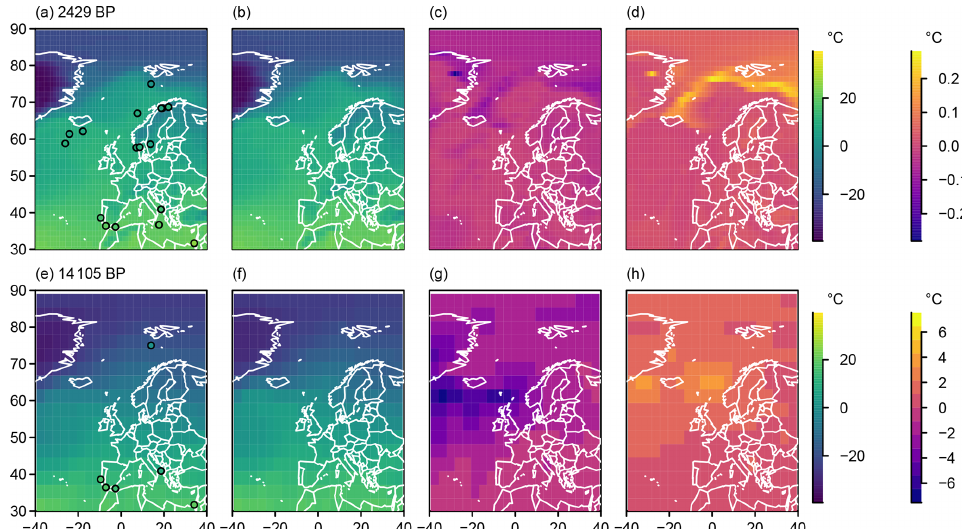
Figure 10. Field information for the analogue search: two examples of 101-year mean annual temperature analogue reconstructions for the European–North Atlantic sector in ◦ C. (a, e) One example analogue, (b, f) local median of all analogues, (c, g) difference of local minimum to local median of all analogues, and (d, h) difference of local maximum to local median of all analogues. Panels (a) to (d) are for the 99% tolerance envelope and the year 2429BP; panels (e) to (h) are for the 99.99% tolerance envelope and the year